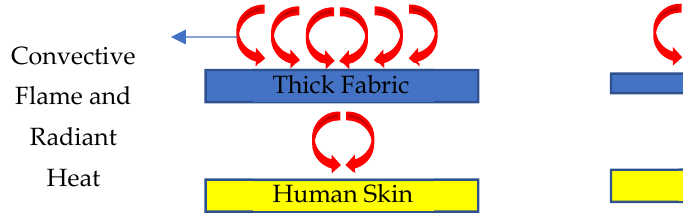
Figure 5. Heat transfer through thick and thin fabrics for HTP.